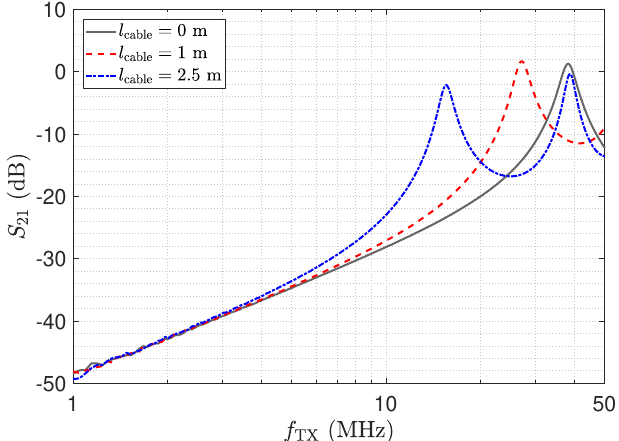
Figure 27. Measurement results for three different cable lengths for the circuit in Figure 21, determined by a network analyser. The input stage of the LCR receiver was not matched to the transmission line. For the λ /2 setup, the blue and the gray trends meet.